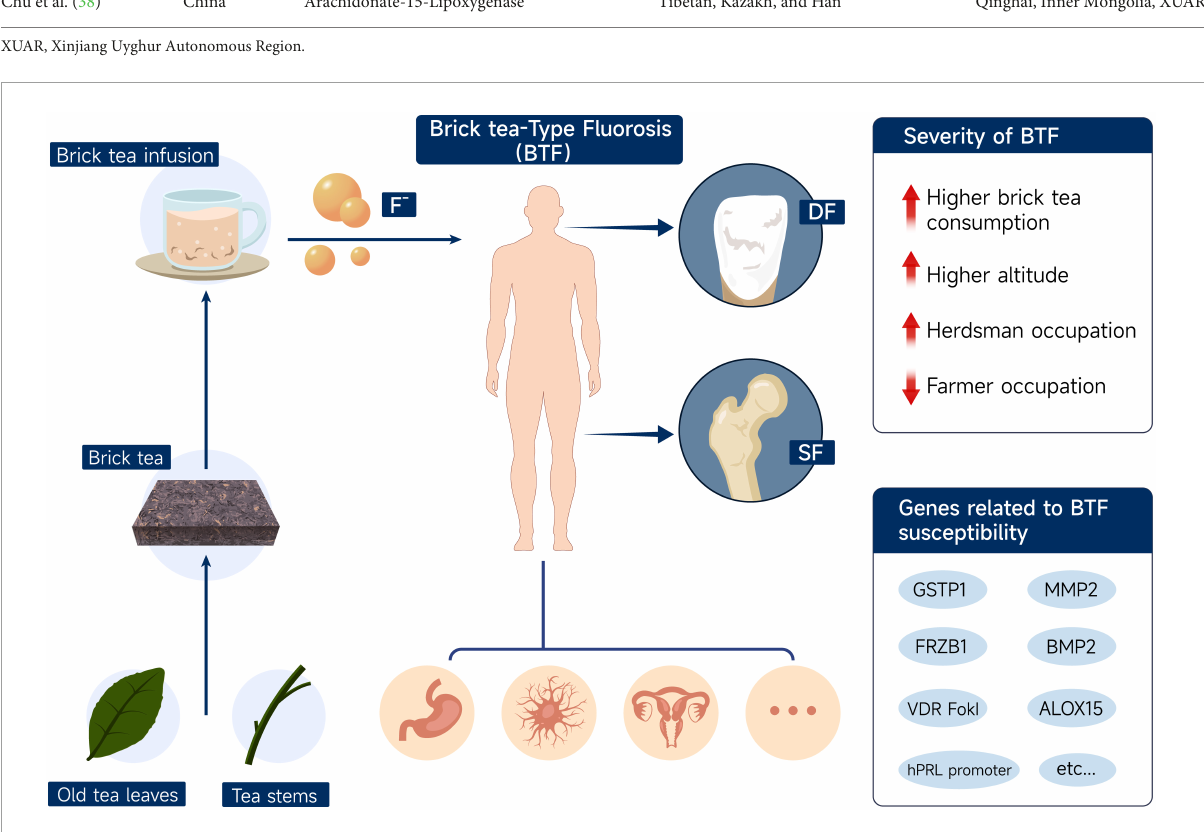
FIGURE2 Schematic diagram of fluoride accumulation in brick tea, the manifestations of brick tea-type fluorosis, and possible influencing factors. DF, dental fluorosis; SF, skeletal fluorosis; BTF, brick tea-type fluorosis.